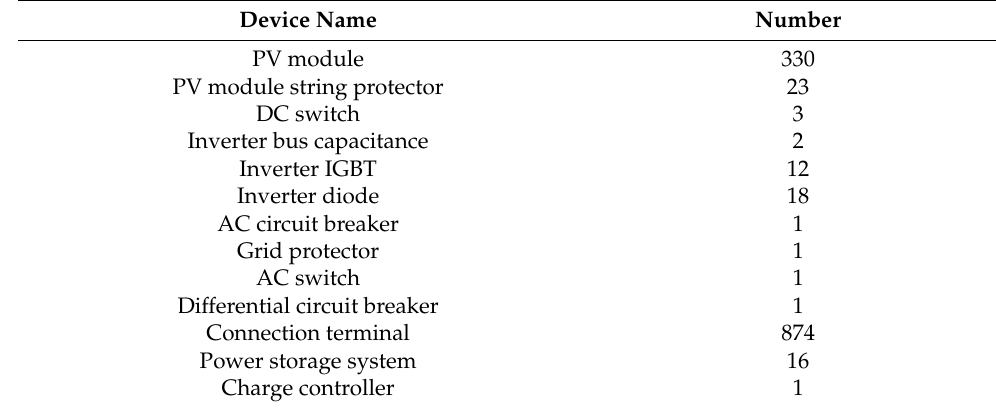
Table 1. Number of components used in 100 kW grid-connected PV power station.